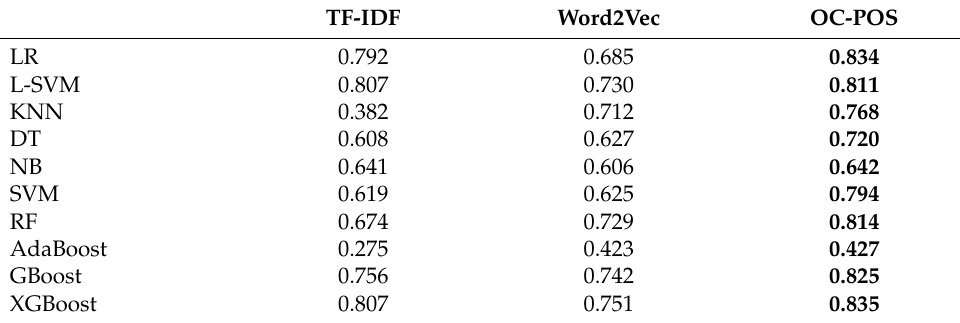
Table 3. Overall weighted F1 of preliminary classification.